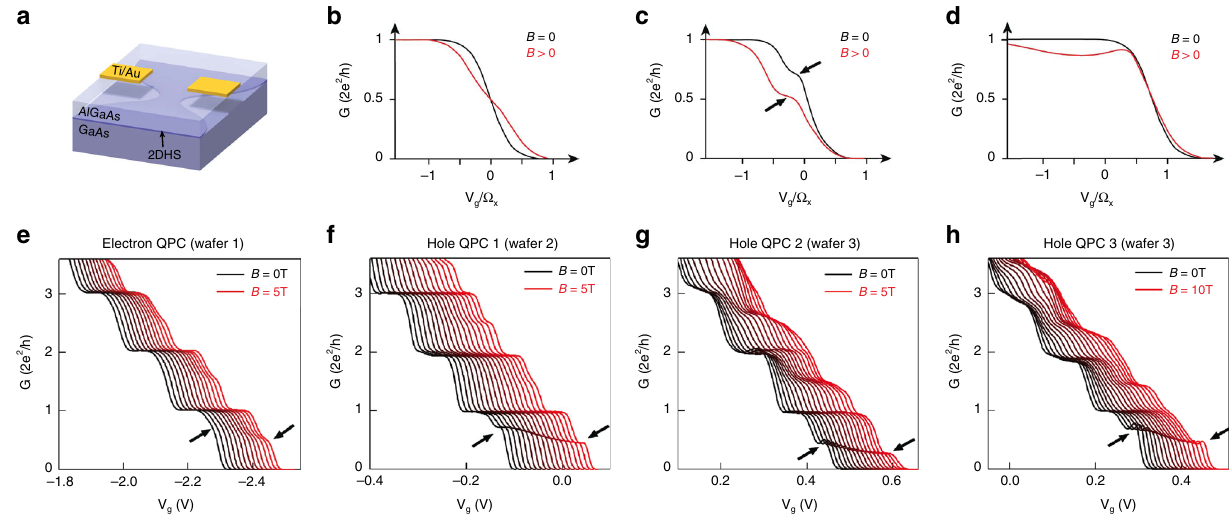
Fig. 1 1D conductance in a QPC in magnetic fi eld with spin – orbit and many-body interactions. a Schematic of a quantum point contact (QPC), with two gate electrodes biased to de fi ne a narrow one-dimensional constriction by locally depleting the 2D electron or hole system in the 2D GaAs/Al x Ga 1 − x As heterostructure. b Schematic showing how the conductance G of non-interacting electrons in a saddlepoint potential would evolve according to the Landauer – Büttiker model, with a smooth rise from 0 to 2 × 2 e 2 / h as the gate potential V g (scaled by the curvature of the 1D constriction Ω x ) is made more negative. Application of an in-plane magnetic fi eld B creates an additional step at G = 0.5 × 2 e 2 / h . c Schematic showing the effect of adding electron – electron interactions, which causes a characteristic shoulder-like anomaly at 0.7 × 2 e 2 / h to appear at B = 0. This evolves to 0.5 × 2 e 2 / h in magnetic fi eld, as indicated by the black arrows. d Including strong SOI with no electron – electron interactions does not change the situation from the non- SOI case at B = 0. For B > 0 the conductance rises from 0 to 2 e 2 / h , then dips as the Fermi energy moves through the spin gap in the dispersion relation. e Measurements of 1D electrons in a QPC, with a waterfall plot of the conductance showing the evolution of the quantisation from 2 e 2 / h at B = 0 (black trace) to e 2 / h in in-plane magnetic fi eld ( B ∥ I ) up to 5 T (red trace). Traces are offset horizontally for clarity. The 0.7 anomaly is indicated with the black arrow for the B = 0 trace, and evolves to 0.5 × 2 e 2 / h . f – h Measurements of 1D holes in three different QPCs (labelled hole QPCs 1 – 3) from two different wafers. Waterfall plots show evolution of the conductance quantisation from 2 e 2 / h at B = 0 (black trace) to e 2 / h with in-plane magnetic fi eld up to 10 T (red trace). The fi eld is applied B ∥ I ( B ⊥ B SOI ) and traces are offset in V g for clarity. The 0.7 anomaly is indicated with the black arrow for the B = 0 trace, and evolves to 0.5 × 2 e 2 / h